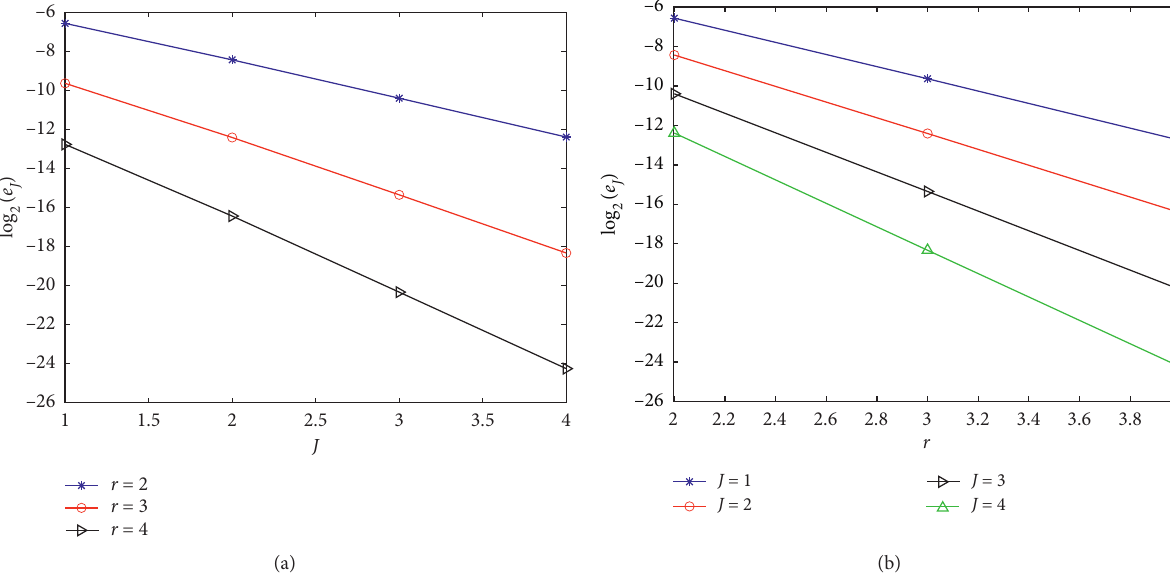
Figure 2: Effects of the multiplicity parameter r and refinement level J for Example 1. Table 2: Order of convergence for Example